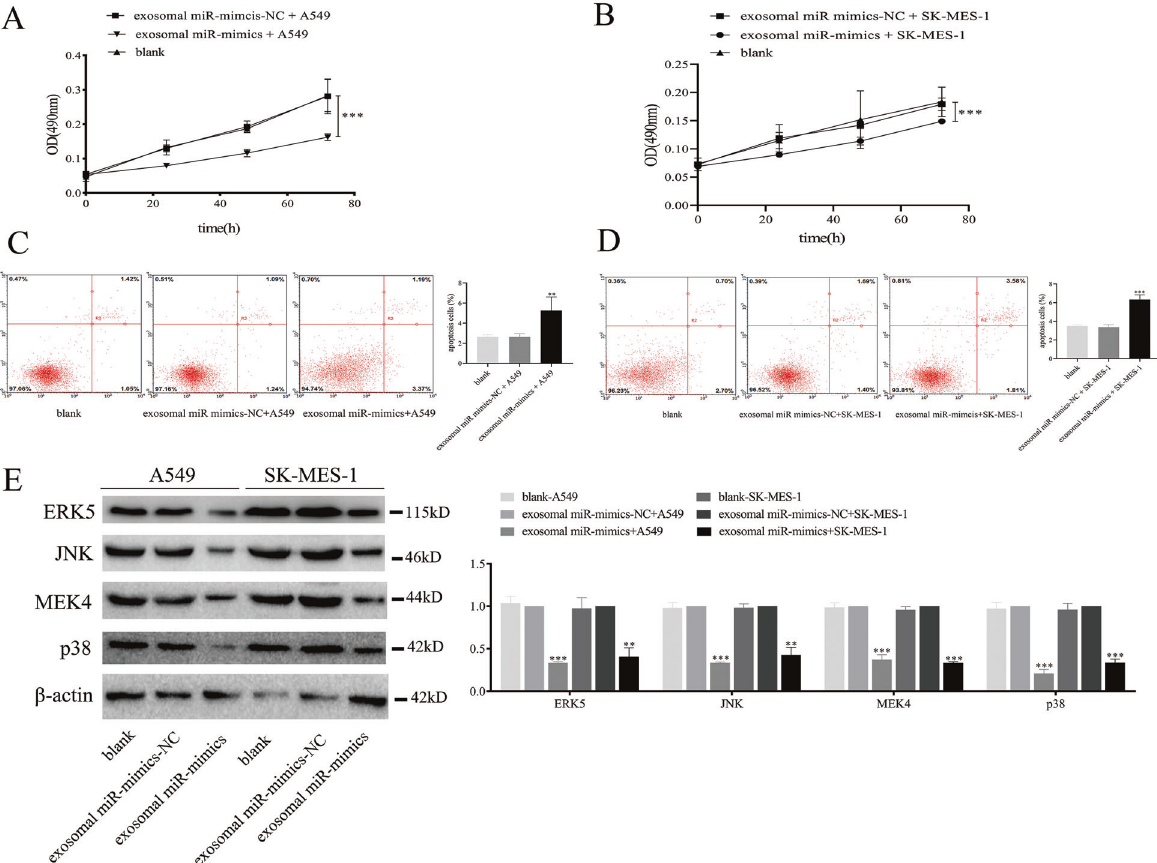
Fig. 7 Exosomal miR-338-3p suppresses NSCLC cell proliferation and promotes NSCLC cell apoptotic rate by inactivating MAPK signaling pathway. A MTS assay of the growth in A549 cells with different treatments at 0, 24, 48, and 72 h. B MTS assay of the growth in SK-MES-1 cells with different treatments at 0, 24, 48, and 72 h. C Elevated exosomal miR-338-3p levels promoted the apoptotic rate of A549 cells. D Elevated exosomal miR-338-3p levels promoted the apoptotic rate of SK-MES-1 cells. E The expression levels of the MAPK signaling pathway